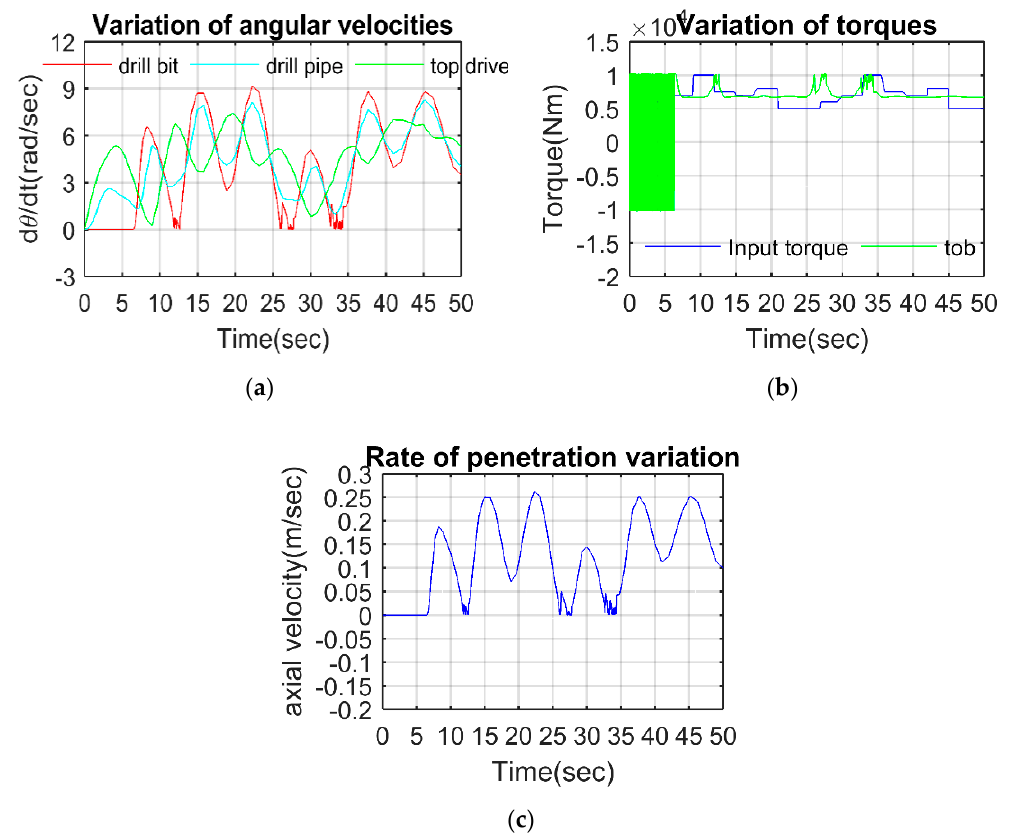
Figure 10. Results of system responses for third scenario: ( a ) angular velocities, ( b ) Tob, ( c ) ROP.